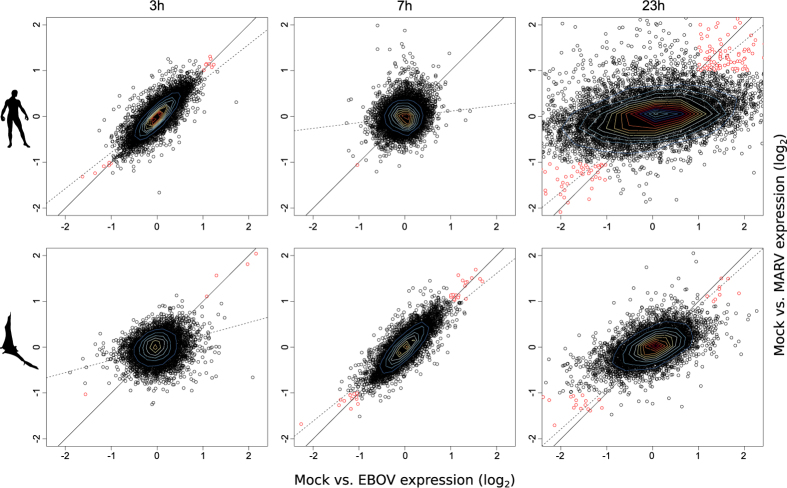
Common gene regulation patterns after filovirus infection.The scatter plots demonstrate the fold changes in expression as determined by DESeq of coding and non-coding RNAs in MARV- and EBOV-infected cells compared with expression in Mock controls 3, 7 and 23 h after EBOV and MARV infections. We observed similar expression patterns in HuH7 cells at 3h p.i. and in the bat cell line 7 h p.i., suggesting that the progress of filovirus infection is slower in R06E-J cells. The scatter plot derived from the differential expression analysis of HuH7 cells at 23 h p.i. shows the large number of differentially expressed genes. A detailed view of the figures (including genes outside of the plotted range of fold changes) can be found in the electronic supplement, Figure ES4B. Genes demonstrating a similar expression after infection with EBOV and MARV and with an abs (log2 (FC)) > 1 are marked in red. Black line: y = x; Dotted line: regression line.